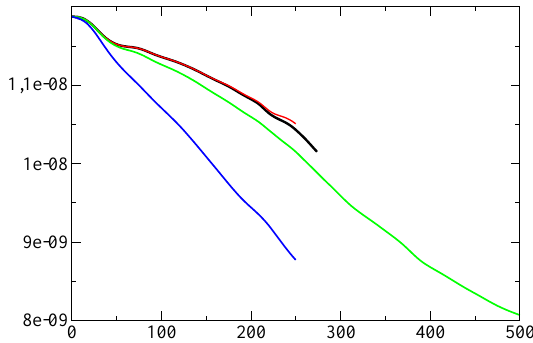
Fig. 4. Quantity ¯ a 1 (see Eq. 9 in the text) (in (ms) − 1 ) measuring the vortical dynamics in the different experiments, as a function of time (in days), for experiments 01 (black) 11 (red), 12 (green) and 13 (blue). Due to the enstrophy cascade there is a fast decrease in vortical dynamics, which depends only weakly on the value of the viscosity parameter. The black and the red curve presenting the same mathematical model (same viscosity) at different resolution, separate after approx 220 days, indicating that the lower resolution run (red) is (slightly) under-resolved.